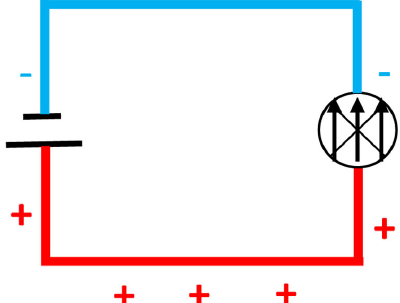
FIG. 3. Model of the electric circuit used in the fields groups to visualize the electric field in an electric